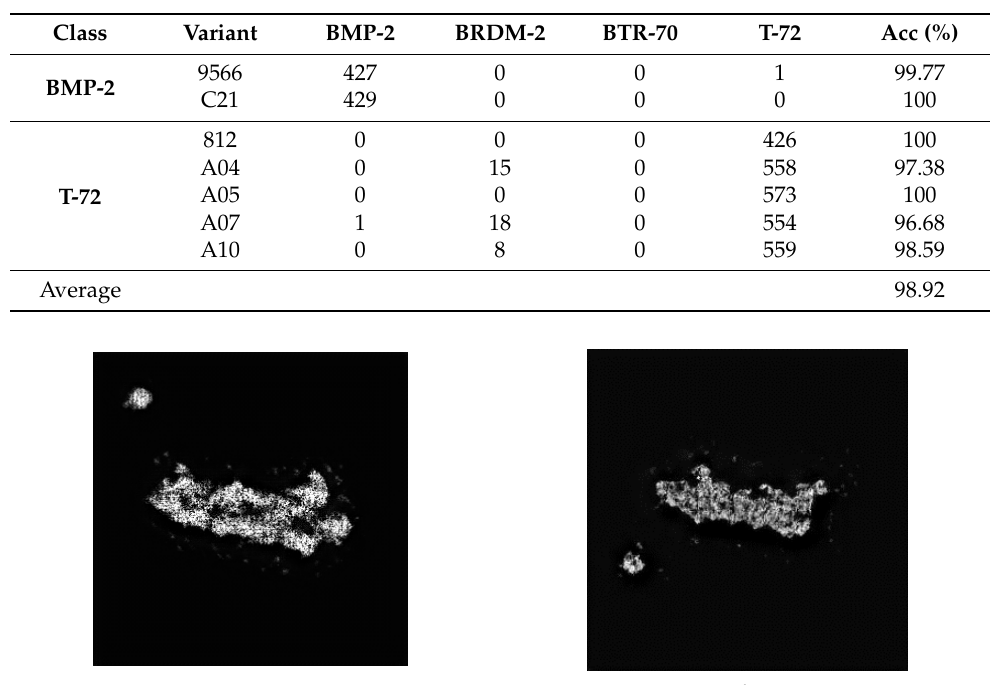
Table 8. The confusion matrix under EOC2 (configuration variant) based on the proposed method. Table 9. The confusion matrix under EOC2 (version variant) based on the proposed method.